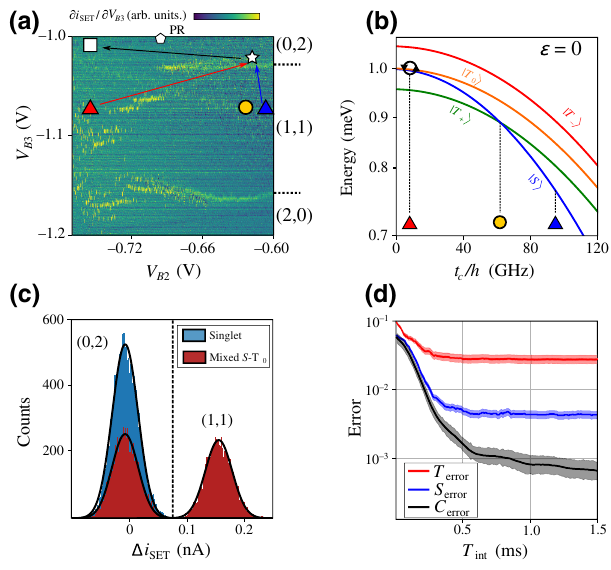
FIG. 1. Frozen Pauli-spin-blockade measurement: proto- col and fidelity. (a) Stability diagram and frozen Pauli-spin- blockade measurement scheme. The voltage V B 2 controls mostly the tunnel coupling of the DQD while V B 3 controls (cid:2) . The tunnel coupling can be controlled from the sub-Hz to GHz regime in a few hundreds of mV applied to the B 2 gate. The blue and red tri- angles indicate the positions used to initialize S and mixed ST 0 spin states, respectively. The yellow circle indicates the position of the ST + avoided crossing. The PSB position is indicated by the white star, the charge-readout position by the white square while the white pentagon indicates the position used to perform selective relaxation of the T 0 spin state to S . (b) Sketch of the energy diagram of the four first spin states of two electrons in a DQD as a function of the interdot tunnel coupling when the two QD chemical potentials are equal ( (cid:2) = 0). At the blue triangle the exchange energy in between the two spins is high enough to preserve the singlet state. At the red triangle the exchange energy is low compared to the magnetic field gradient and mixing of the initial S spin state occurs with the T 0 . At the yellow circle, the S and T + states are degenerated and mixing occurs via the Over- hauser magnetic field and spin-orbit coupling. (c) Histogram of 50 000 single-shot measurements with an integration time of T int = 1.5 ms. Following Connors et al. [6] we define a thresh- old (dashed line) to discriminate the (1,1) and (0,2) charge state minimizing the readout error. (d) Fidelity of the frozen PSB read- out procedure as a function of the electrometer signal integration time. For T int < 0.5 ms, the spin-readout error is limited by the charge-readout error C error . For longer integration times, the spin- readout error saturates and reaches S error = 0.43 ± 0.05% and T error = 2.7 ± 0.4%. The uncertainty is represented by the shade around the solid